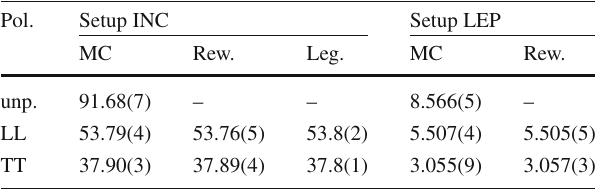
Table 1 Total cross-sections (in 10 − 6 pb) in the INC and LEP setups, obtained with polarized amplitudes (MC) and with the matrix-element reweighting method (Rew.). In the INC setup also the results of Legendre-polynomial projections (Leg.) are shown. Numerical errors are given in parentheses